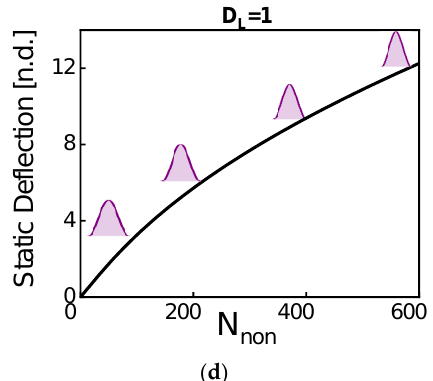
Figure 4. The static deflection with axial load for hybrid shape for different dome lengths. ( a ) D L = 0.3, ( b ) D L = 0.5, ( c ) D L = 0.75, and ( d ) D L = 1. The initial rise of the dome is equal to 2 µm. The asymmetry of the static shape is clear for lower dome length.